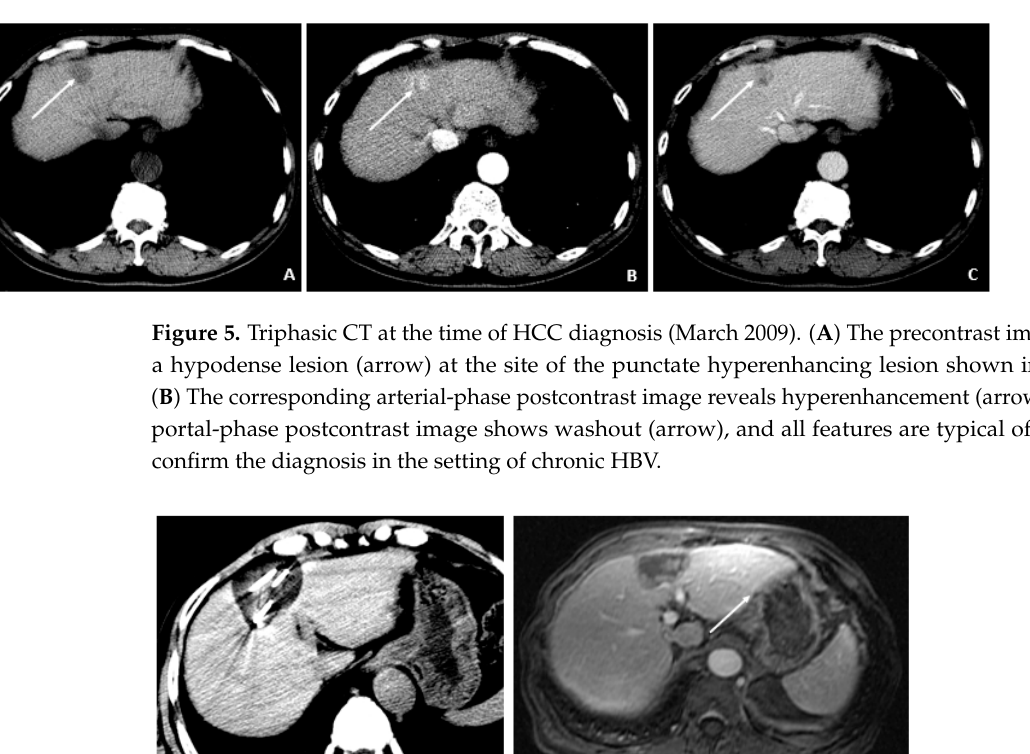
Figure 4. Initial MRI with normal AFP and elevated %L3 (July 2008). ( A ) The axial T2-weighted gradient echo image shows a small hyperintense lesion (arrow) in segment 4A. A second hyperintensity (dashed arrow) corresponds to a hemangioma. ( B ) The corresponding axial T1-weighted fat-suppressed arterial-phase postcontrast image shows hyperenhancement (arrow) in the lesion subsequently found to be a small HCC, although currently without associated features to clinch the diagnosis. Without washout, capsule appearance, or other typical HCC findings, the lesion is indeterminate.